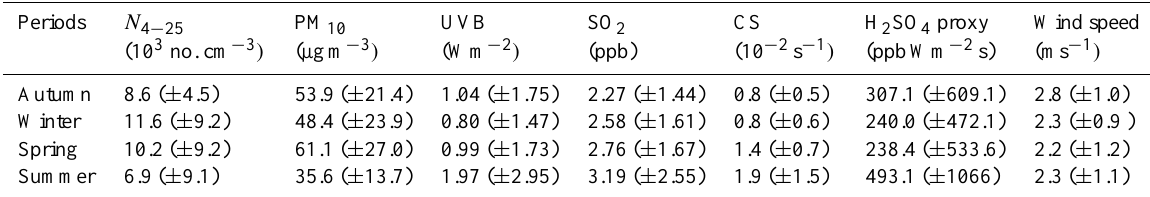
Table 3. Average of N 4 − 25 , PM 10 , UVB, SO 2 , condensation sink (CS), H 2 SO 4 proxy and wind speed of different seasons. Standard deviation values are shown in parentheses. (Note: the data of the rainfall observations were not used in the